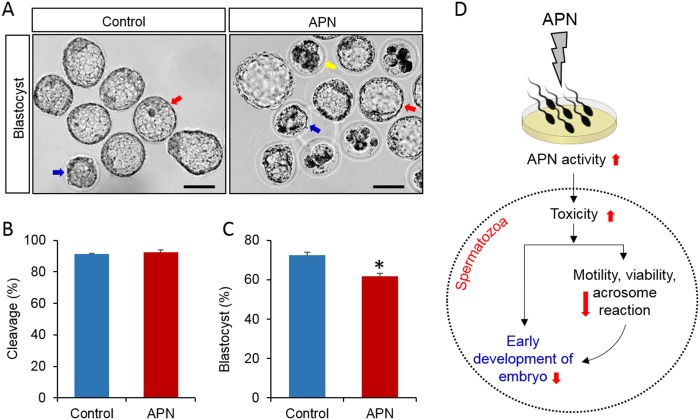
Effect of recombinant APN on fertilization and embryonic development.(A) Blastocyst quality in the control and APN-treated groups (Bar = 50 μM). Red, blue, and yellow arrows indicate grade 1, 2, and 3 blastocysts, respectively. (B) Difference in cleavage rate between the control and treated groups (P = 0.568). (C) Blastocyst formation rate in the control and treated groups (P = 0.008). Data represent the mean ± SEM of three replicates. *P < 0.05, calculated using two-tailed Student’s t-test. (D) Effect of APN on mouse spermatozoa and its hypothetical mechanisms of action. High APN activity induces toxicity in spermatozoa and subsequently decreases sperm motility, viability, and acrosome reaction. Ultimately, the affected spermatozoa display pathological conditions induced by dysregulation of early embryonic development.